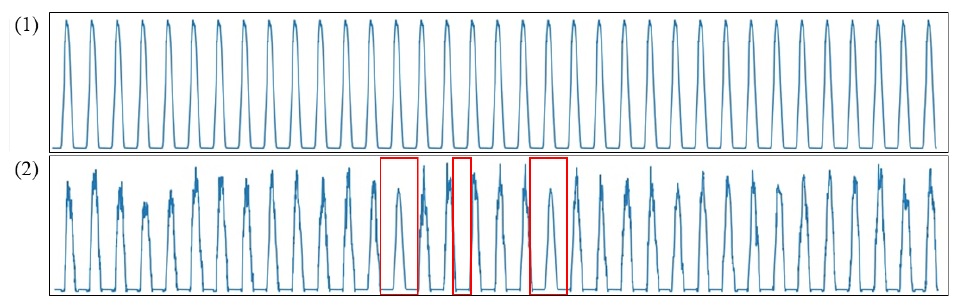
Figure 5. Filling in the gaps by extracting the seasonal component. ( 1 ) seasonal component of time-series; ( 2 ) reconstructed time-series. The red boxes show the reconstructed sections of the time